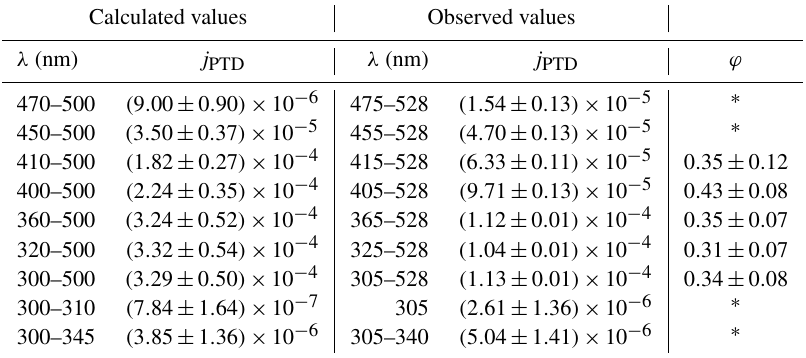
Table 1. Measured and calculated photolysis frequencies of the photolysis of 2,3-pentanedione for different wavelength ranges as well as calculated quantum yields for a temperature of 298K. The given wavelengths for the observed values refer to the peak wavelengths of the outermost activated LEDs. Values marked as ∗ are not reliable because the difference between the estimated wavelength range and the actual spectral width is affecting the final results too